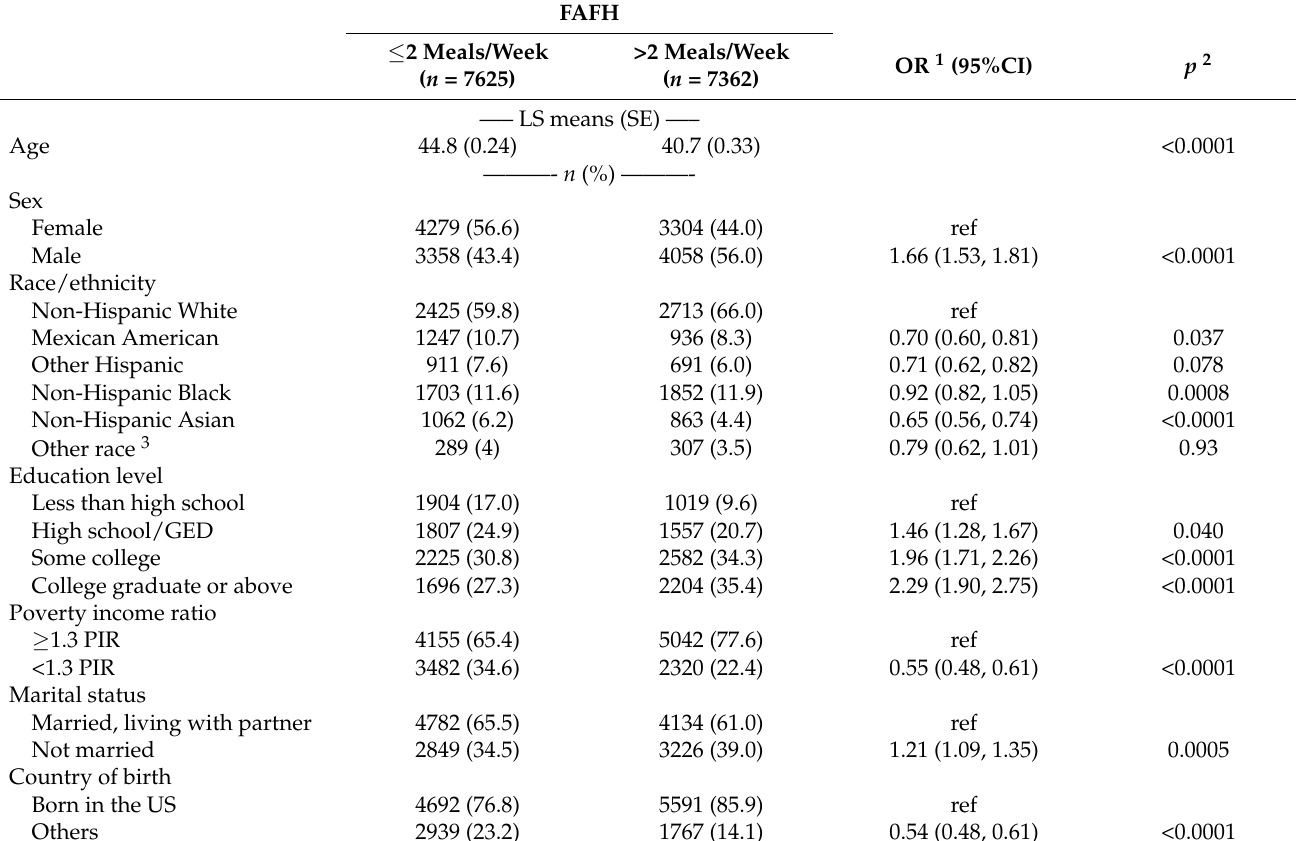
Table 1. Descriptive assessment for regression models by FAFH frequency ( n = 14,987).